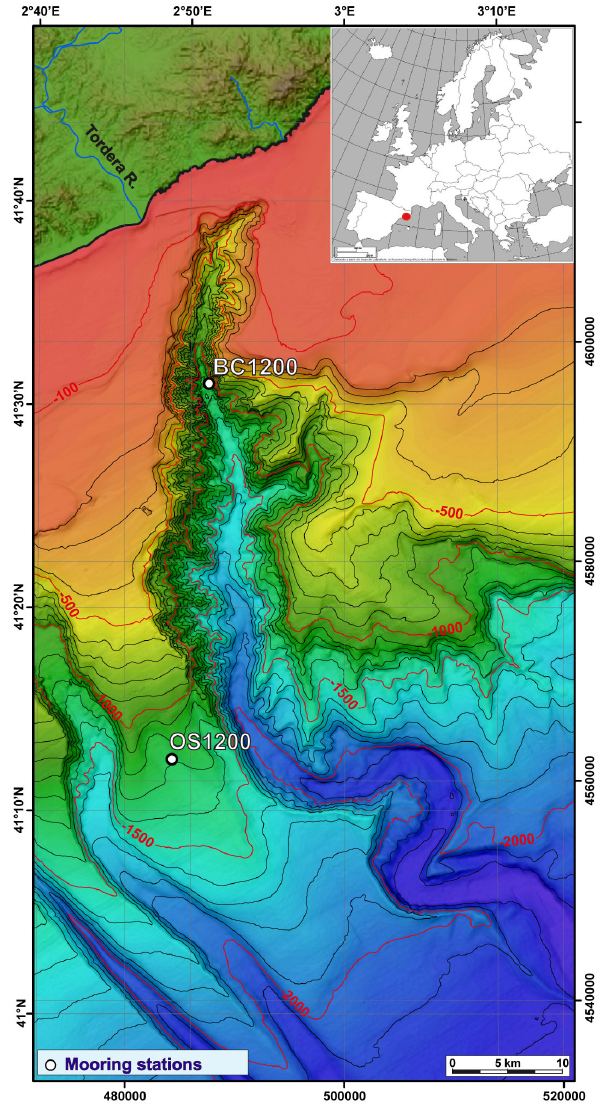
Fig. 1. Bathymetric map of Blanes canyon showing the location of the mooring station in Blanes canyon axis (BC1200) and in the adjacent southern open slope (OS1200). The location of Tordera River and the meteorological buoy is also shown. Depth in